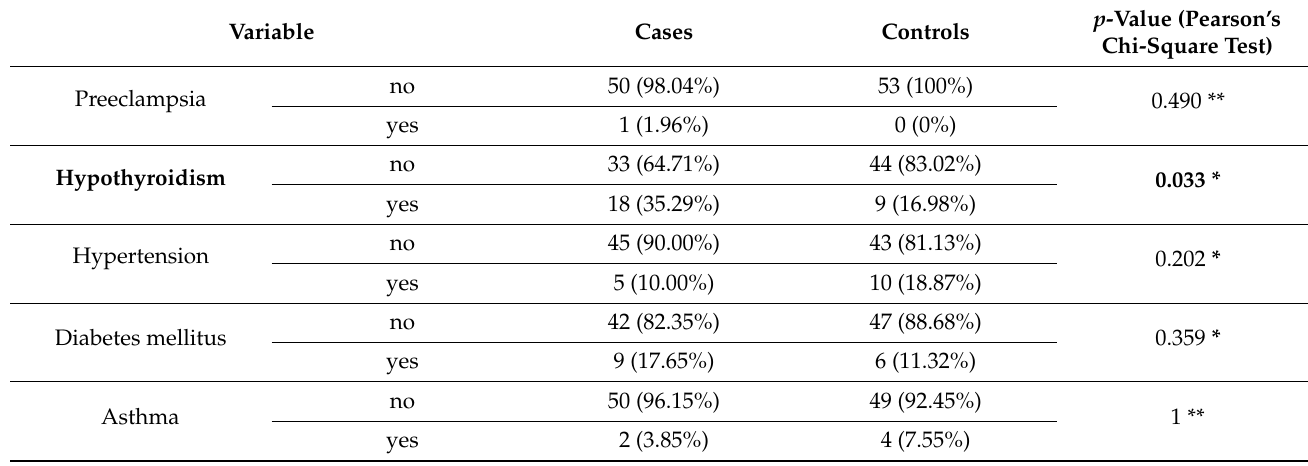
Table 4. Patient’s comorbidities.